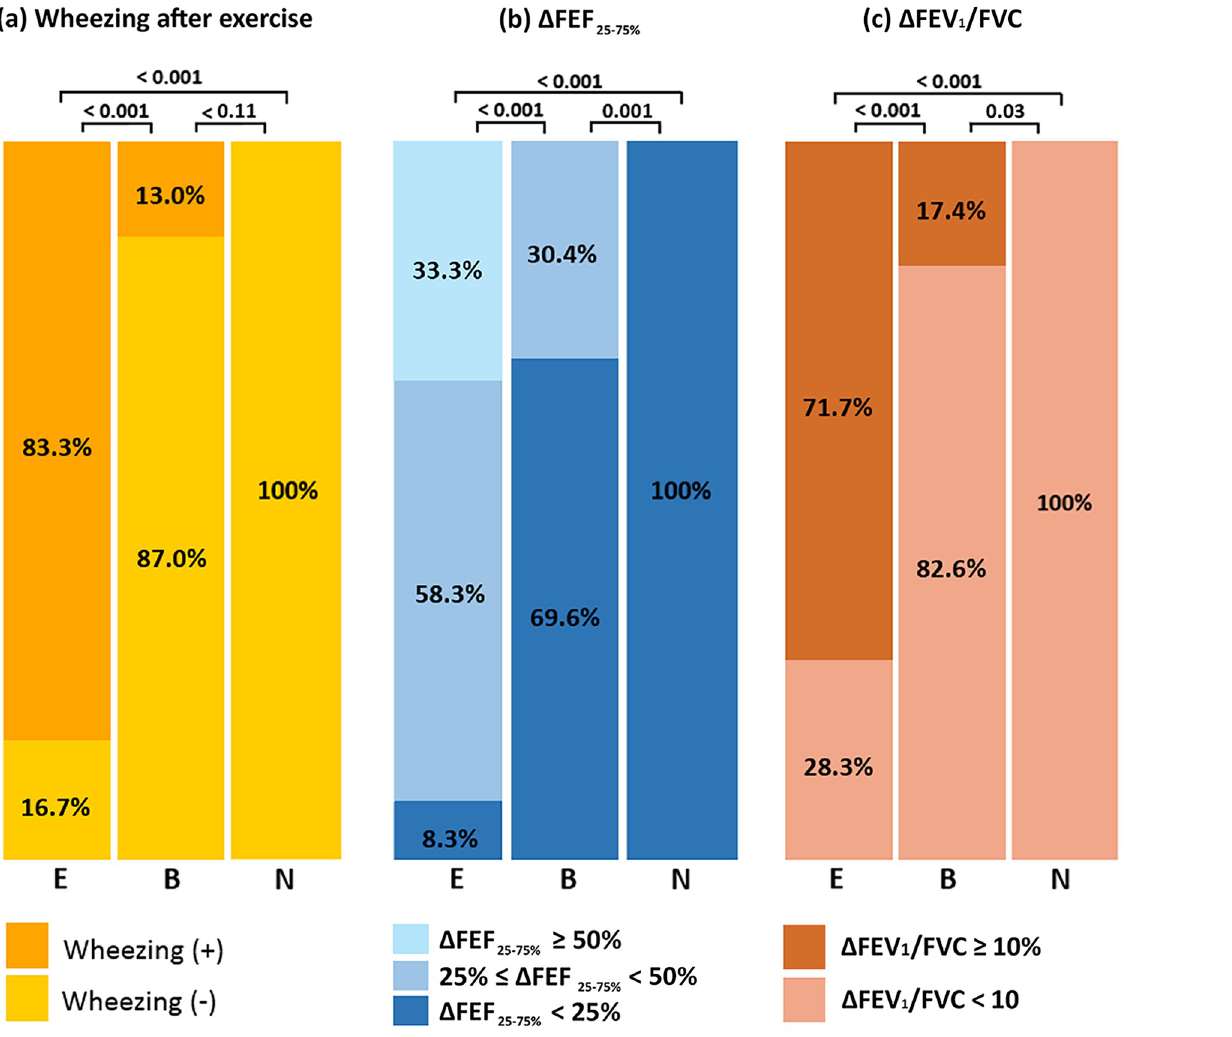
Fig 2. Distinct characteristics of the definite EIB group compared with the borderline EIB and normal